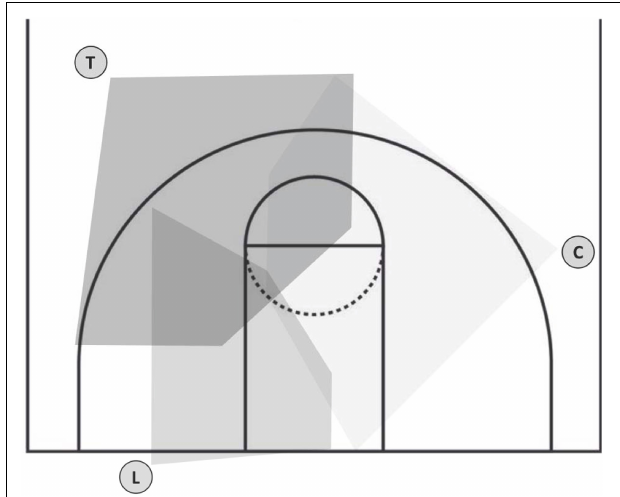
FIGURE 1 | Coverage of gaze areas of the three referees’ positions (L, lead; T, trail; C, center) in the 3PO system, predefined by the guidelines for referees [modified figure according to FIBA (2016), p.